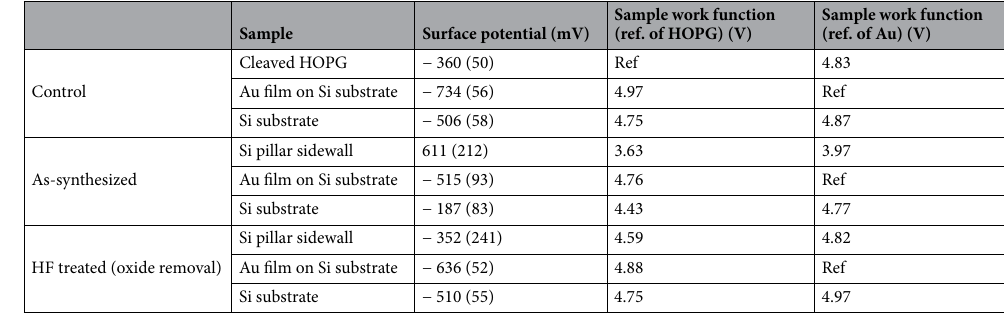
Table 1. The calculated work function of the Si pillars before and after oxide removal in hydrofluoric acid (HF). Mean and standard deviation (in parenthesis) of the contact potential difference (CPD) are shown in the column of surface potential. Highly-oriented pyrolytic graphite (HOPG) was used as a calibration sample with a known work function of 4.6 eV 51 . The patterned Au film as a reference (work function of 5.1 eV), where the Si micropillars were dispersed (Fig.